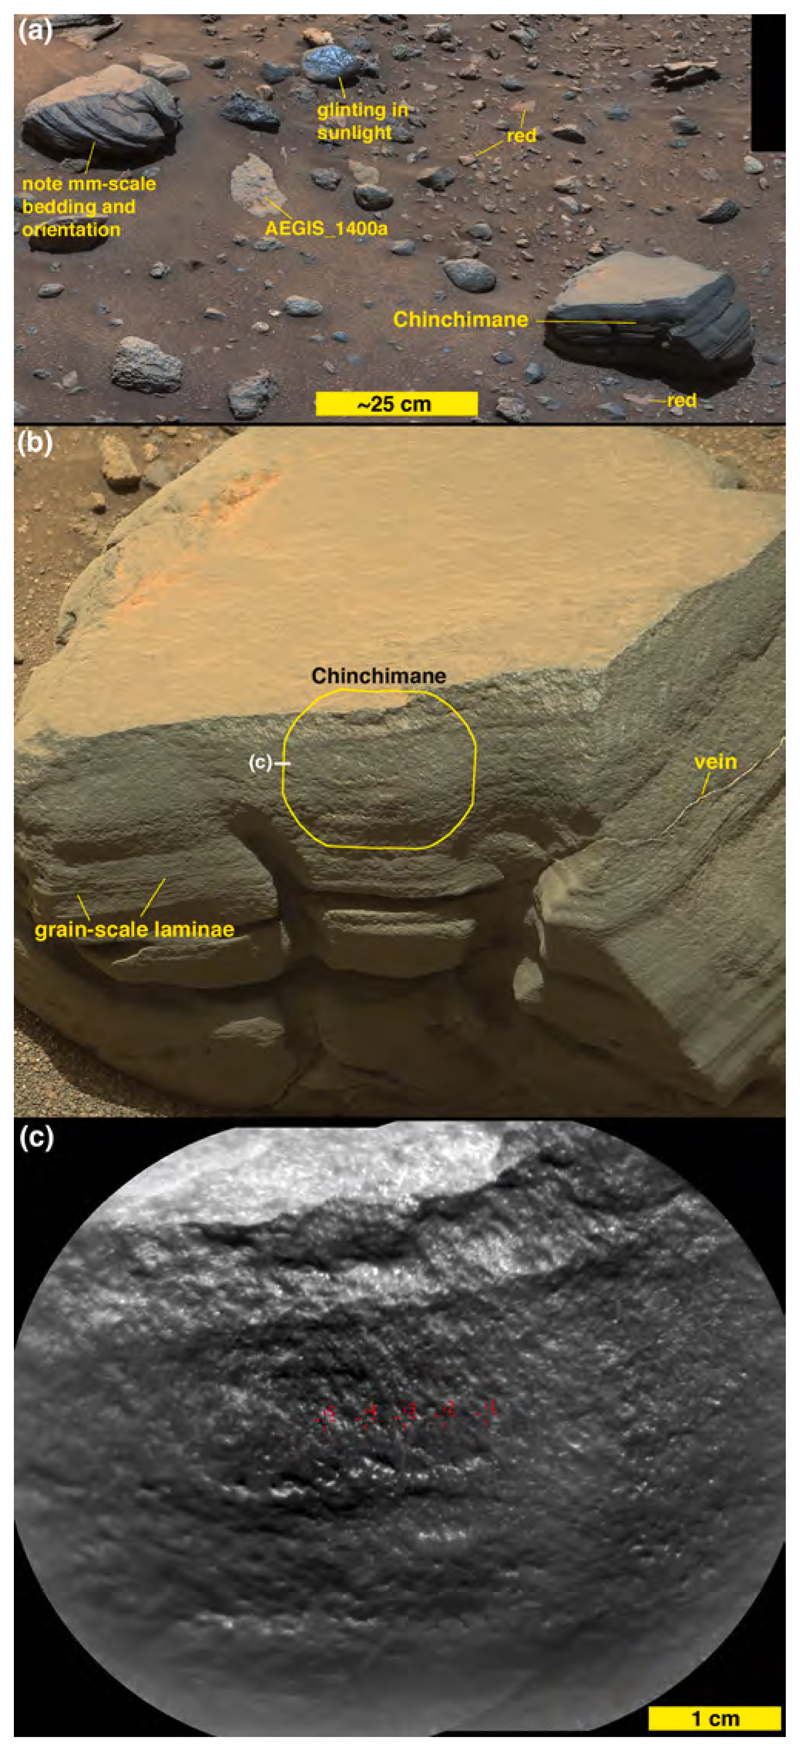
(a) Local context for layered gray sandstone cobble target Chinchimane. Note the differences in cobble orientation relative to their bedding structure, as well as the diversity of cobble colors, response to sunlight, and sedimentary structure and texture. (b) Mastcam-100 view. Bedding is approximately parallel and thin (sand grain scale thickness). A fracture filled with a while material (vein) cuts across bedding. The yellow outline indicates the location of the ChemCam RMI coverage shown in (c), where a few individual sand grains can be identified in a well cemented and well sorted sandstone. (For interpretation of the references to color in this figure, the reader is referred to the web version of this article.)